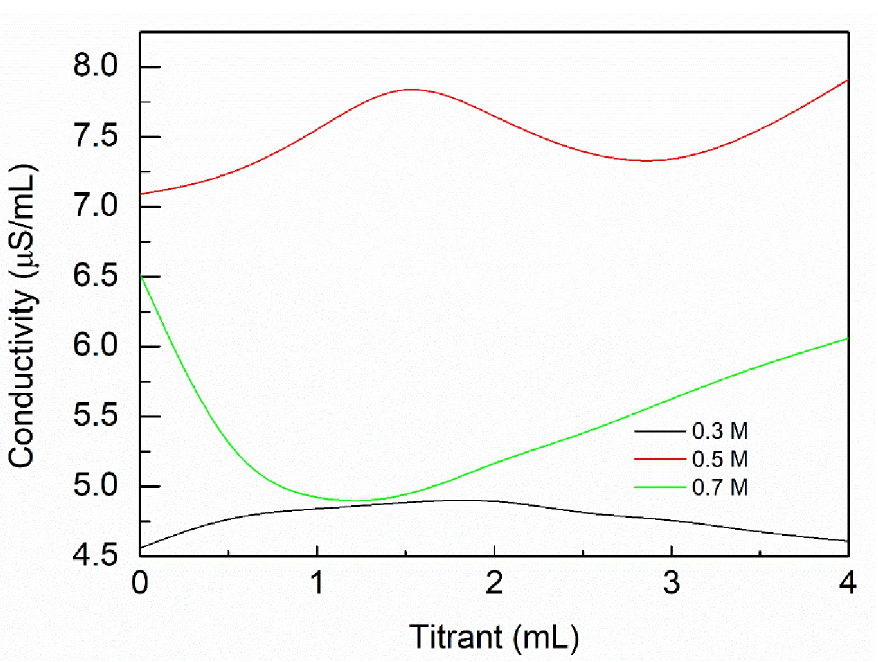
Fig 7. Influence of titrant concentrations on conductivity